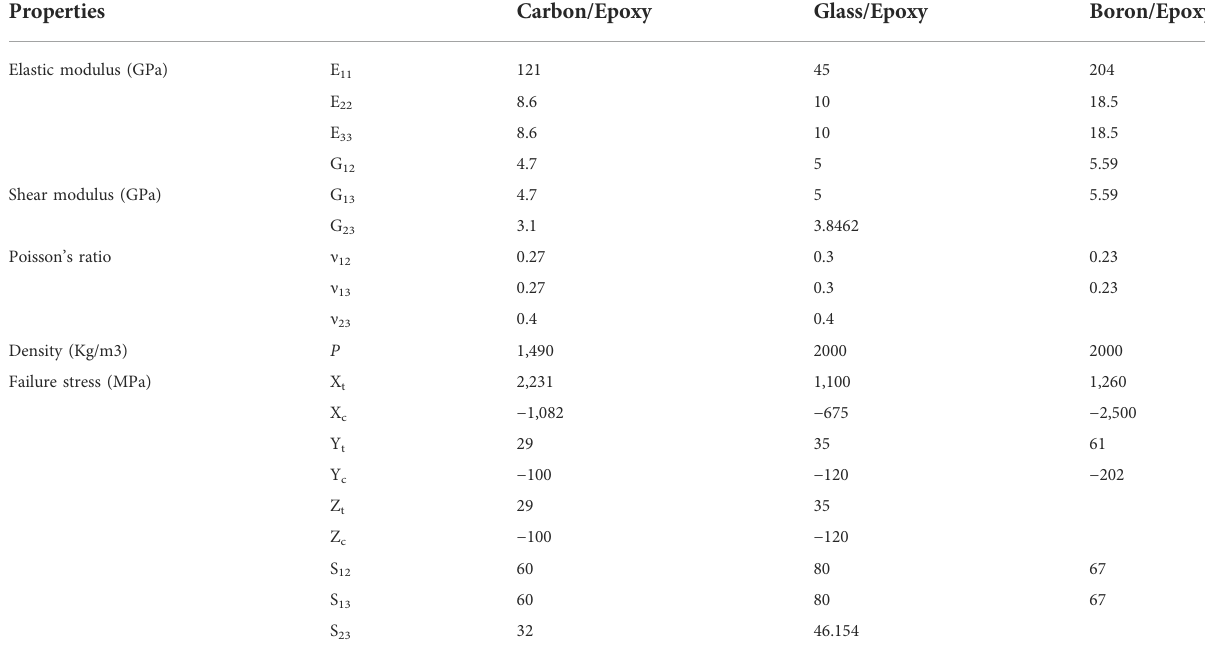
TABLE 1 Mechanical properties of the composite materials (ANSYS, 2017).